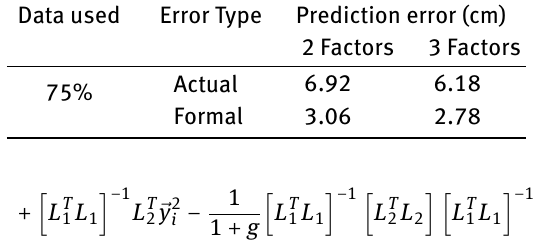
Table 4: Testing of the FA interpolation errors Data